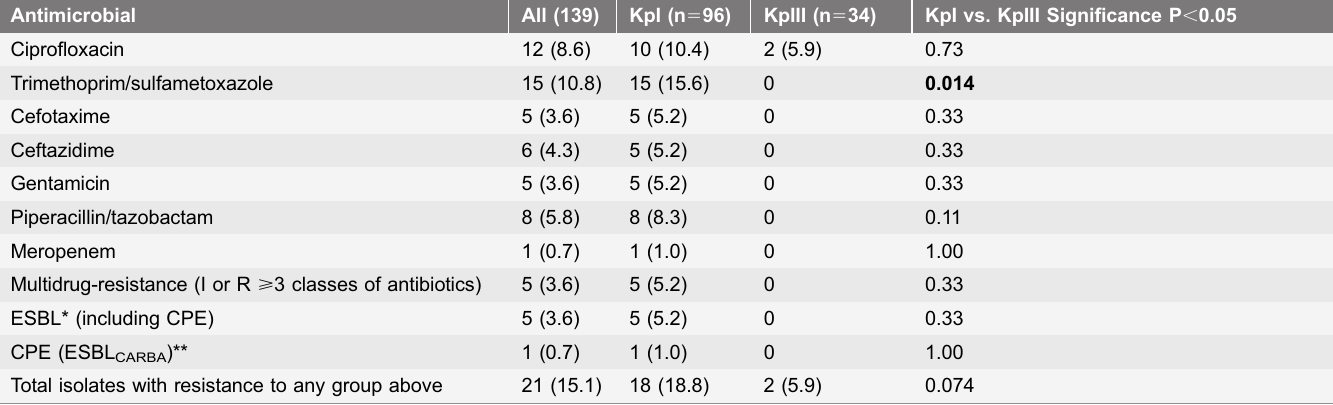
Table 5. No of isolates with non-susceptibility (intermediate and resistant) to